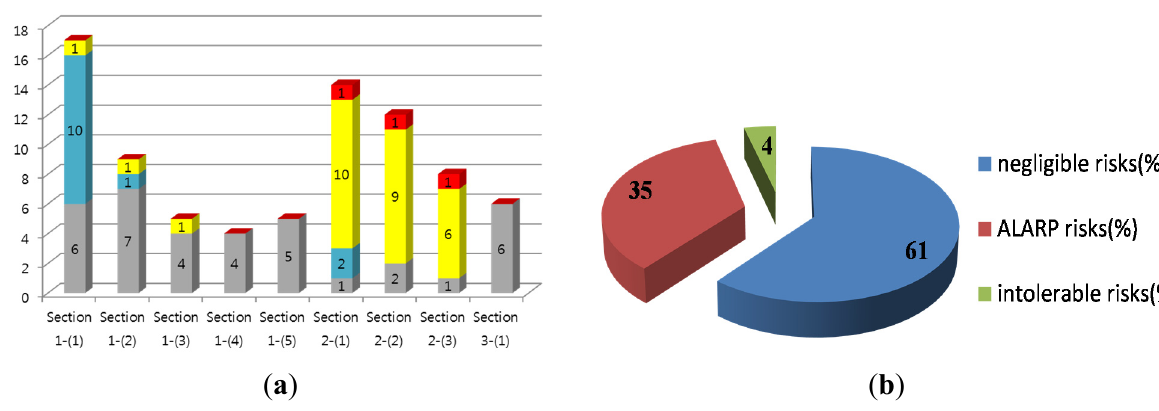
Figure 8. Hazard distribution ( a ) and proportions of negligible, ALARP and intolerable risks ( b